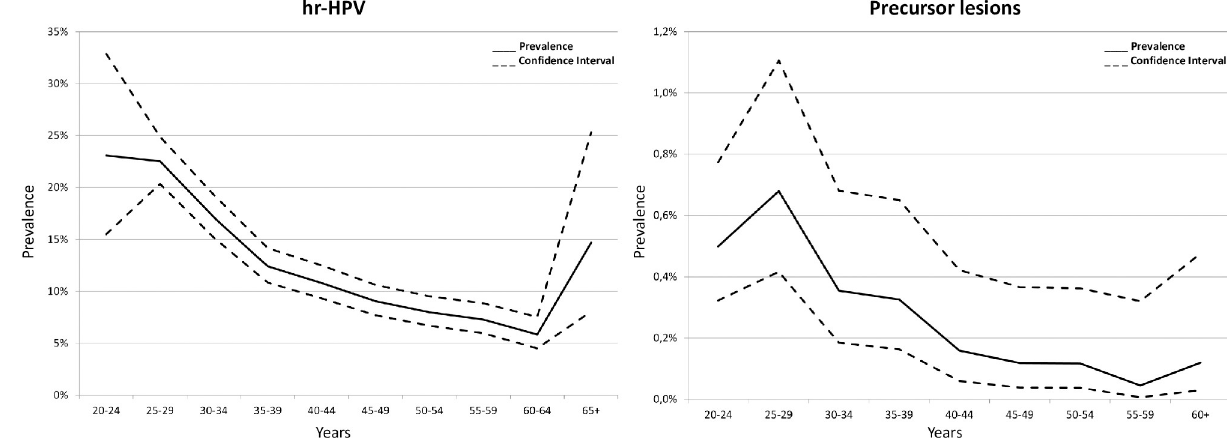
Fig 2. Prevalence and 95% confidence intervals used for modelling of hrHPV and precursor